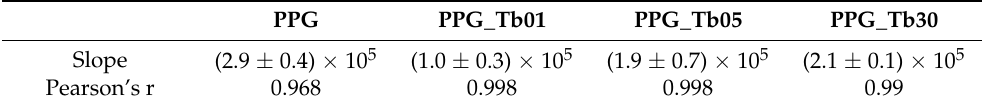
Table 4. Parameters of fitted linear functions for glass samples (dose 50–2000 Gy).